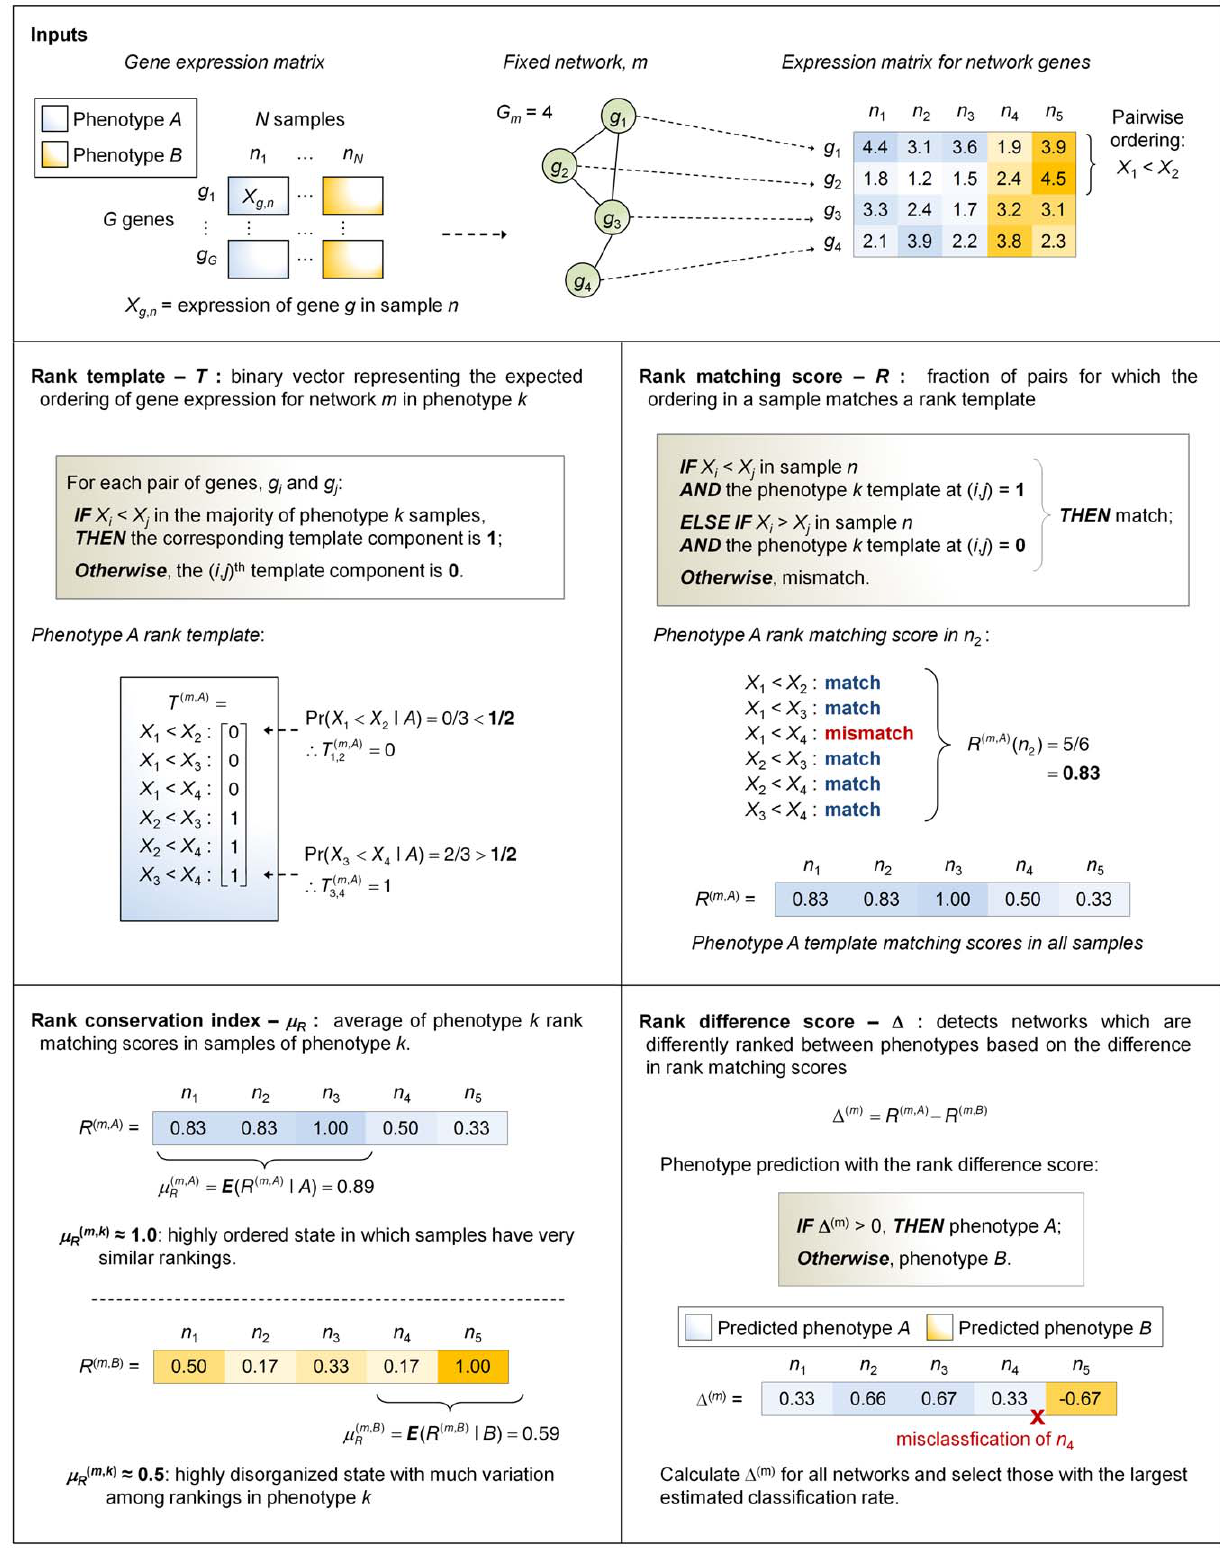
Figure 1. Overview of Differential Rank Conservation (DIRAC) methods.